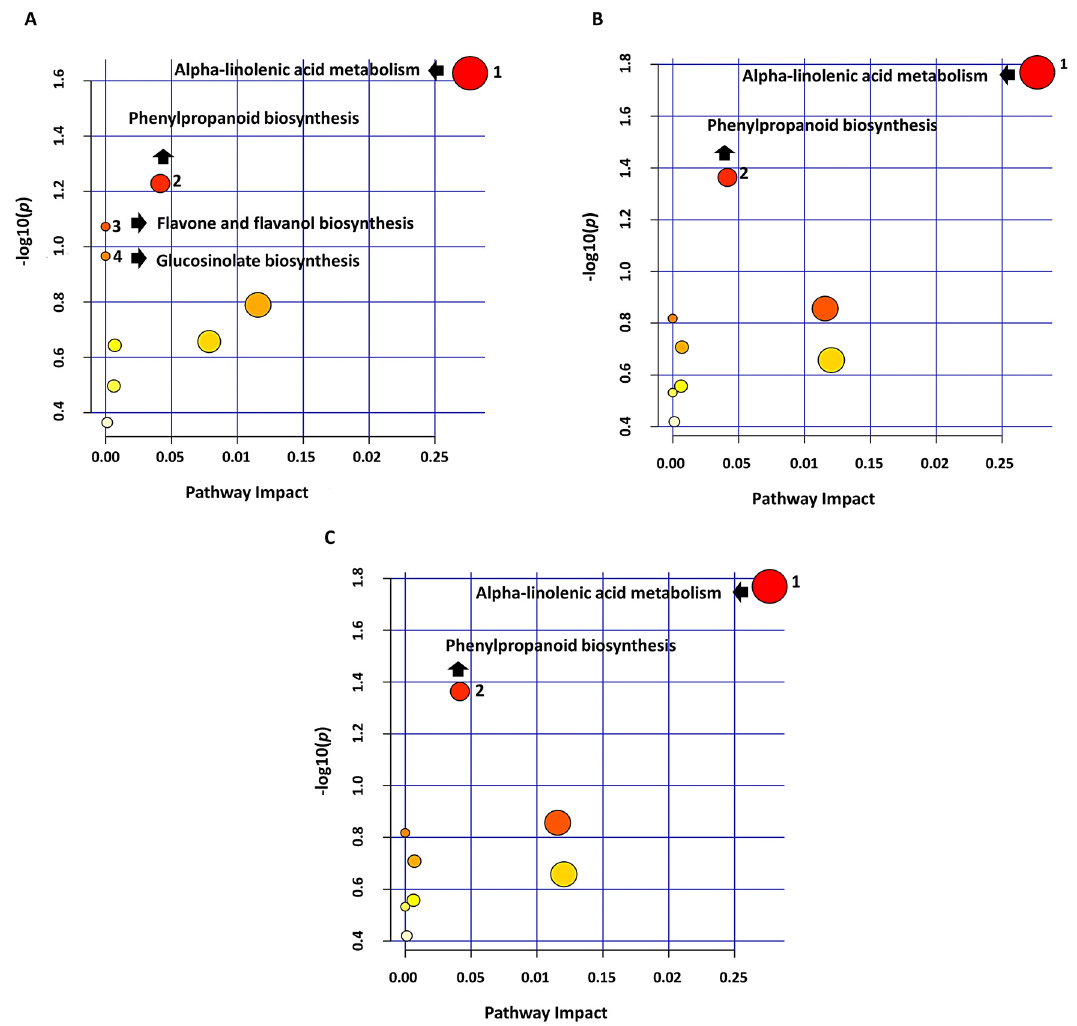
Figure 6. Metabolome view of metabolic pathways (MetPA) mapped from identified metabolites. Metabolite KEGG IDs from both LPS chemotype-treated WT, lbr2-2 or bak1-4 were mapped to path- ways as displayed. ( A – C ) represents the metabolome view for the WT, lbr2-2 and bak1-4 , respectively. The graphs were arranged such that the p -values from the pathway analysis are on the y -axis and the impact values from the pathway topology analysis on the x -axis. The colour gradient of the circles (pathways) from light yellow to dark red indicates lower to higher significance, respectively.